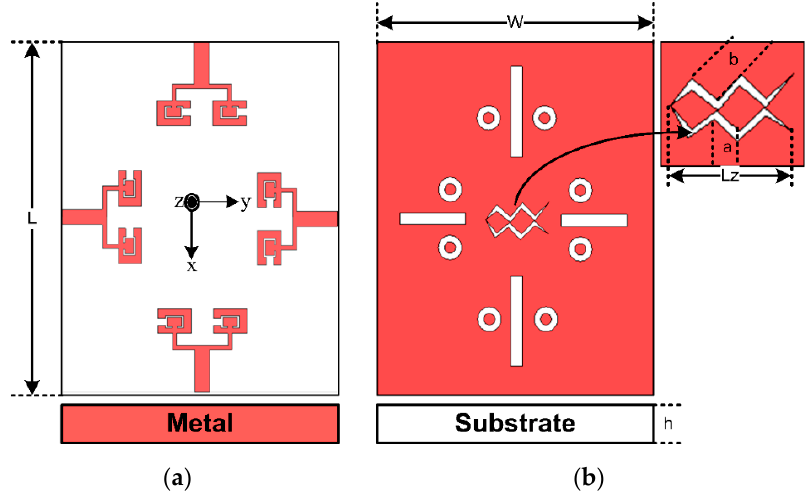
Figure 1. Proposed Multiple-Input-Multiple-Output (MIMO) Antenna module ( a ) Top view ( b ) bottom without a Defected Ground Structure (DGS).